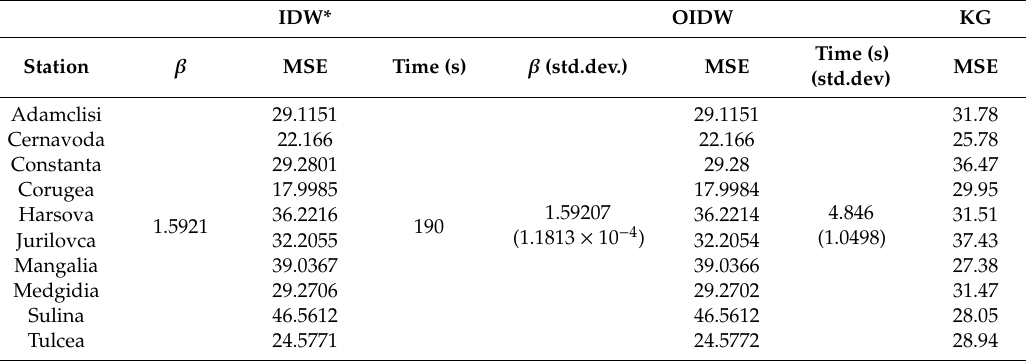
Table 3. Parameter β values obtained in experiments performed using the series recorded at all (51) meteorological stations, in the scenario A2. For OIDW, the values in the parentheses are the standard deviation of the parameter identified, computed over the 50 independent runs. Comparison with